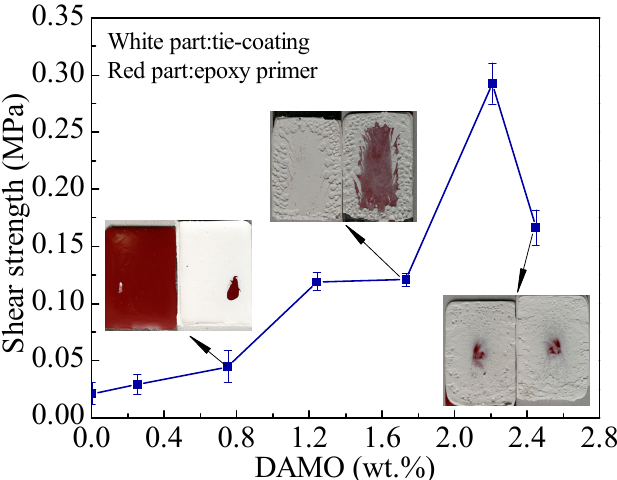
Figure 7. Effect of the DAMO content on shear strength of the tie coating/epoxy primer composite coatings.